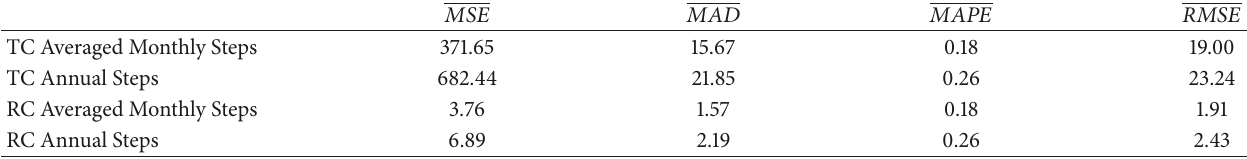
Table 11: Average for main measures of error for MR-OUP after 1000 MC simulations 2013-2014.